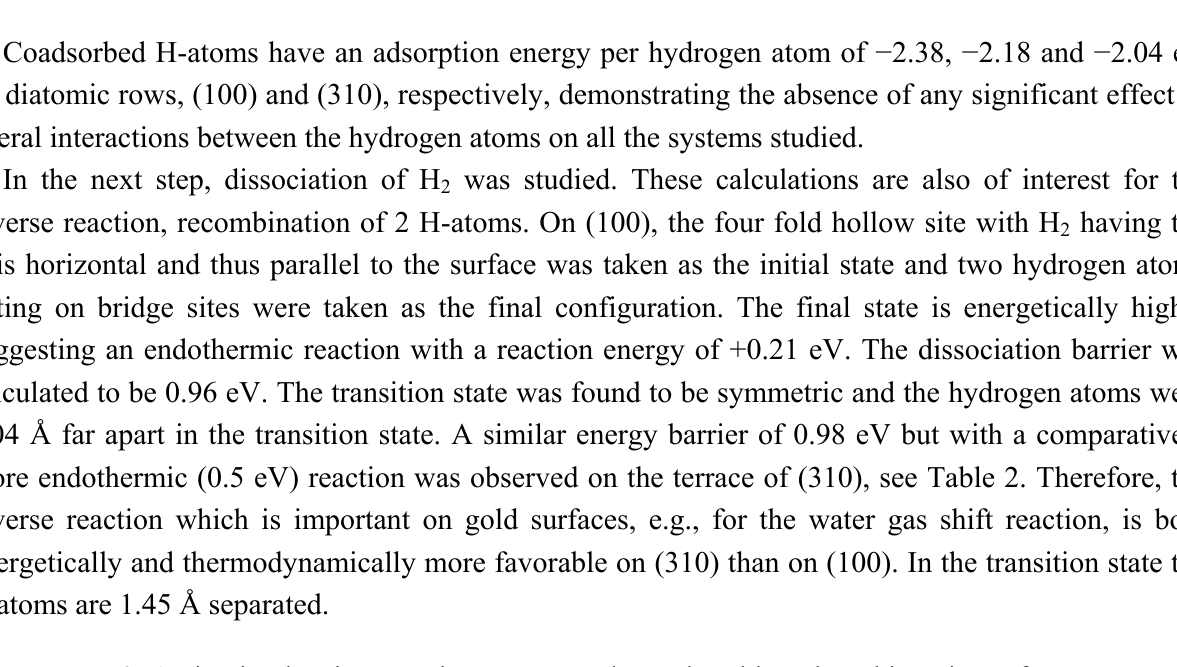
Table 2. Activation barrier, reaction energy and H-H bond length and imaginary frequency in TS on different gold